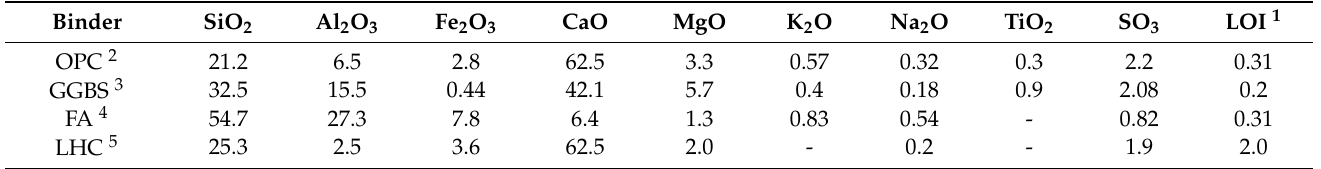
Table 2. Chemical composition of cementitious materials